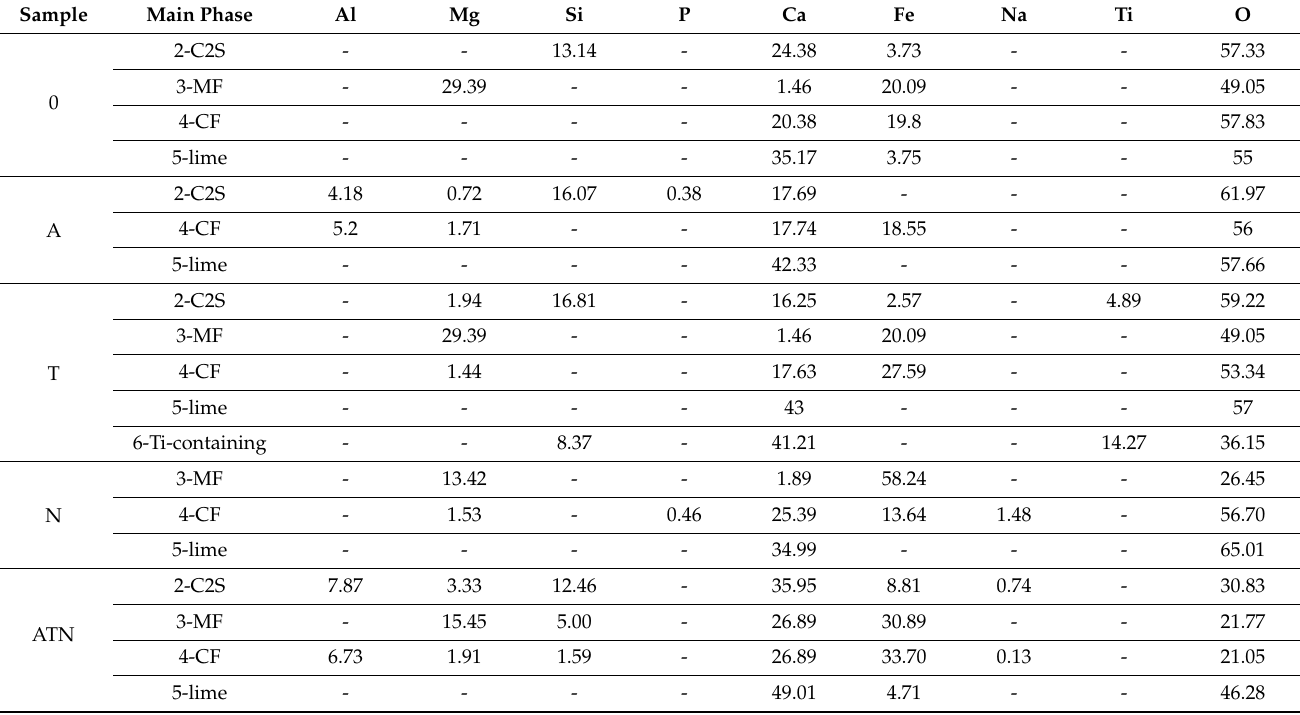
Figure 7. Microstructure and phase composition of lime samples with slag. (( a ) Sample 0, ( b ) Sample A, ( c ) Sample T, ( d ) Sample N, and ( e ) Sample ATN; 1: slag, 2: C2S, 3: MF, 4: CF, 5: lime, 6: Ti-containing). Table 4. EDS analysis results (wt.%).